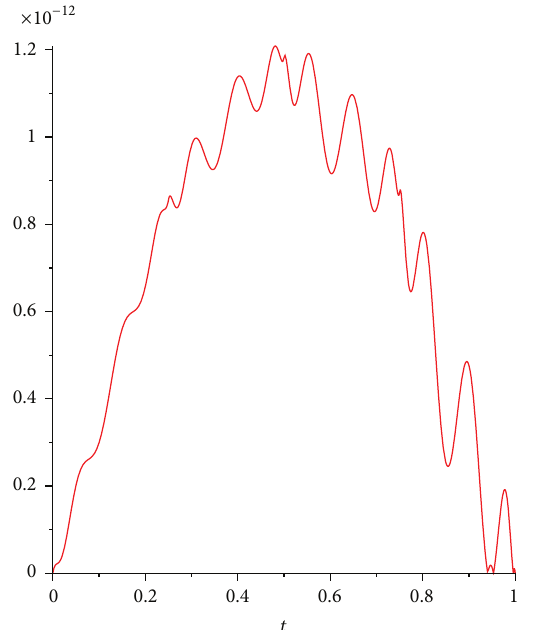
Figure 3: The graph of absolute errors for Example 6 for 𝐾 = 10 , and 𝑀 = 9